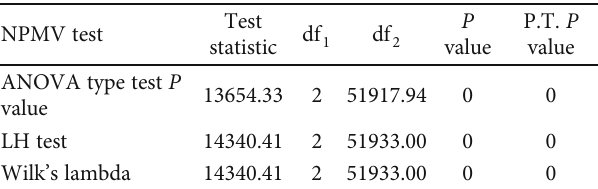
Figure 9: Schematic of the oscillation and transient shock tests. Table 5: Nonparametric inference results for the comparison of multivariate data